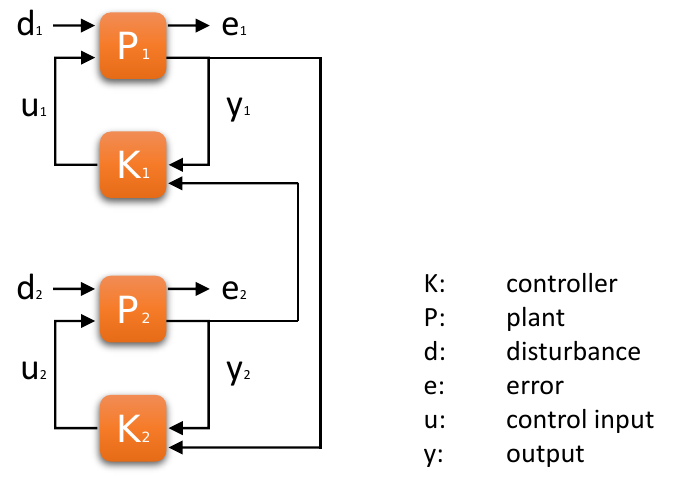
Figure 5. Two plants P 1 and P 2 with their controllers K 1 and K 2 . The plants are not coupled, but the controllers are. Here, y 1 influences K 2 and y 2 influences K 1